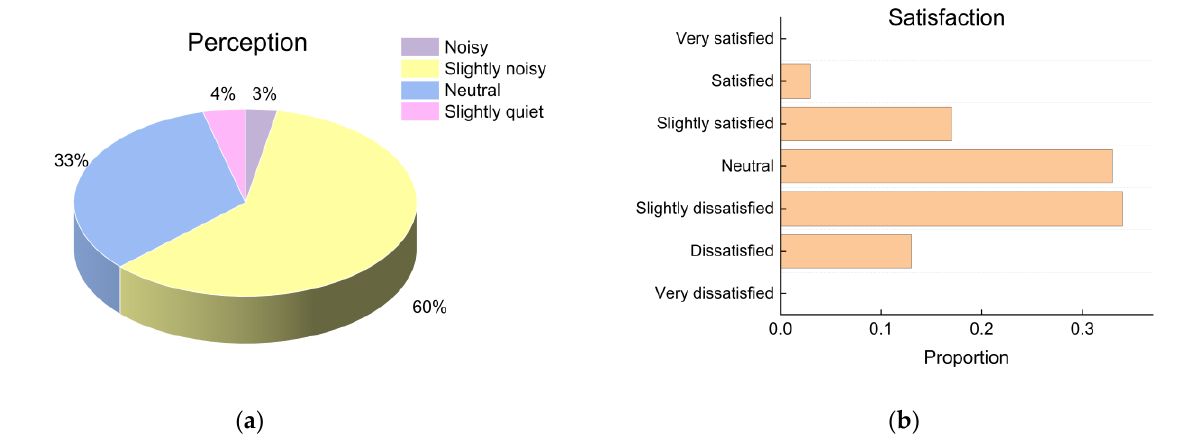
Figure 8. Subjective evaluation of noise: ( a ) perception; ( b ) satisfaction proportions.